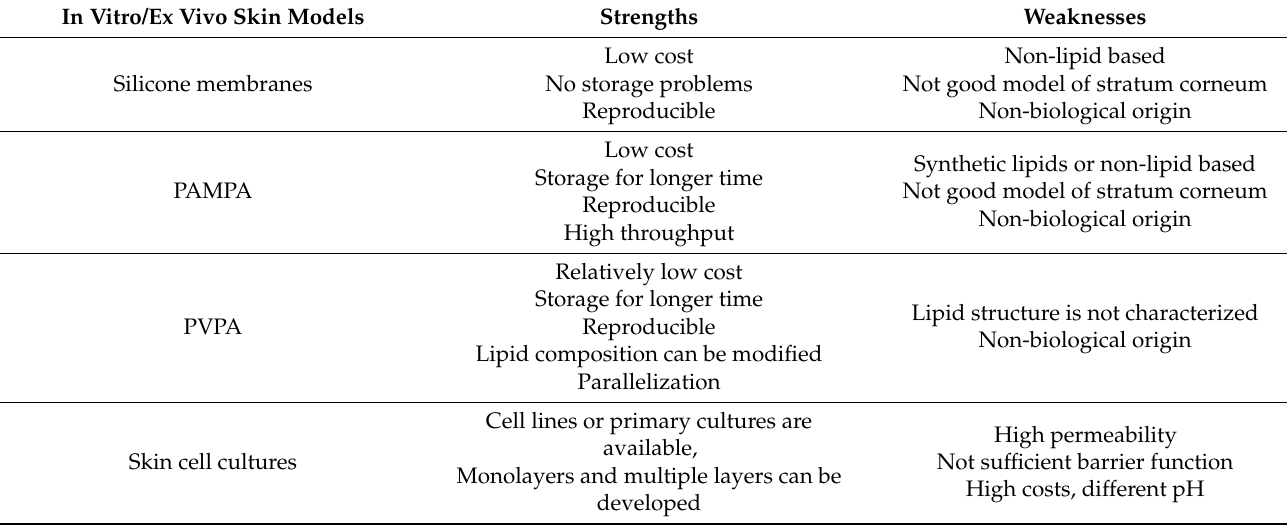
Table 6. Comparison of strengths and weaknesses of different in vitro and ex vivo skin models used in permeability studies (modified from Flaten et al., 2015